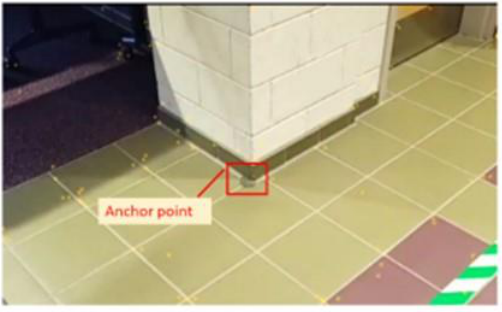
Figure 5. Selecting anchor points in reality.